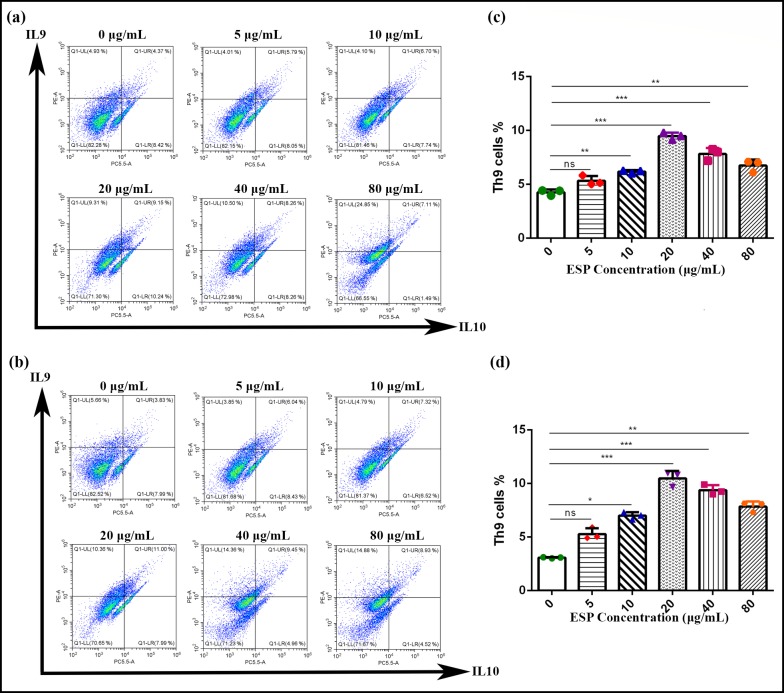
In vitro effects of ESPs on the population of Th9 cells by flow cytometry.a: Dot plot analysis (gated on CD2+CD4+ T cells) of Trial 1, PBMCs derived-T helper-9 cells treated with control (0 μg/mL) and different concentrations of ESPs (5,10, 20, 40, 80; μg/mL) using representative intracellular cytokine antibodies (IL-9 and IL-10). b: Dot plot analysis of trial 2; c:, Proportion of Th9 cells’ population in different groups of trial 1. d:, Proportion of Th9 cells’ population in different groups of trial 2. Data are presented of the two experiment and mean ± SD representative of triplicate experiments (*P < 0.05, (**P < 0.01, ***P < 0.001).